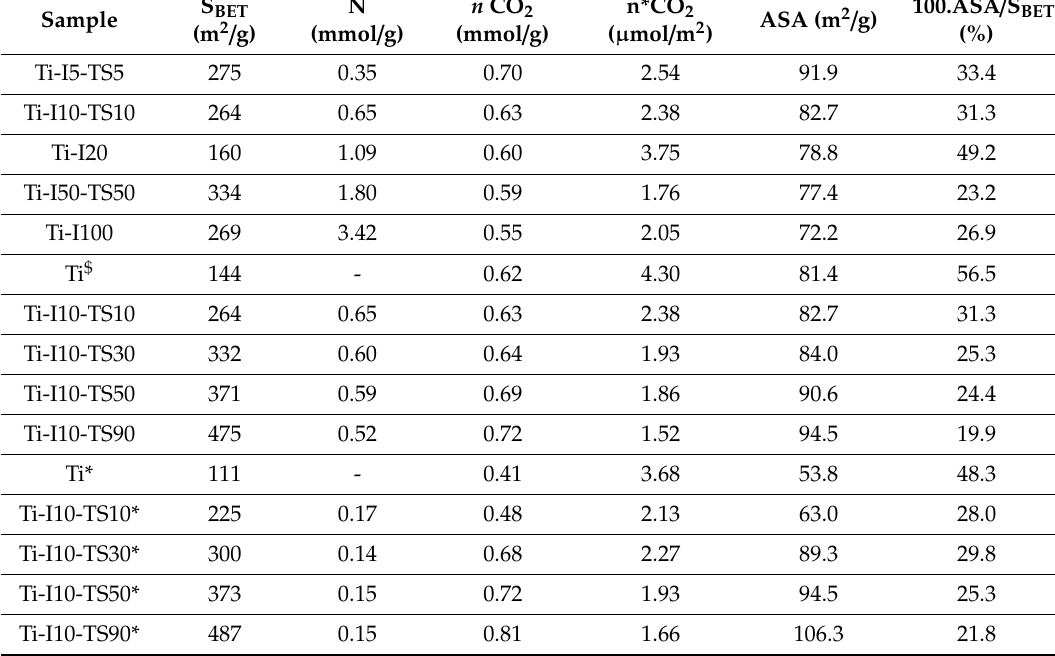
Figure 10. CO 2 sorption isotherms at 25 °C measured on the ( a ) Ti-I10-TSx and ( b ) Ti-I10-TSx* samples; (x = 10, 30, 50, 90). Table 3. Structural parameters and CO 2 uptake values at 25 ◦ C for the studied Ti-MO